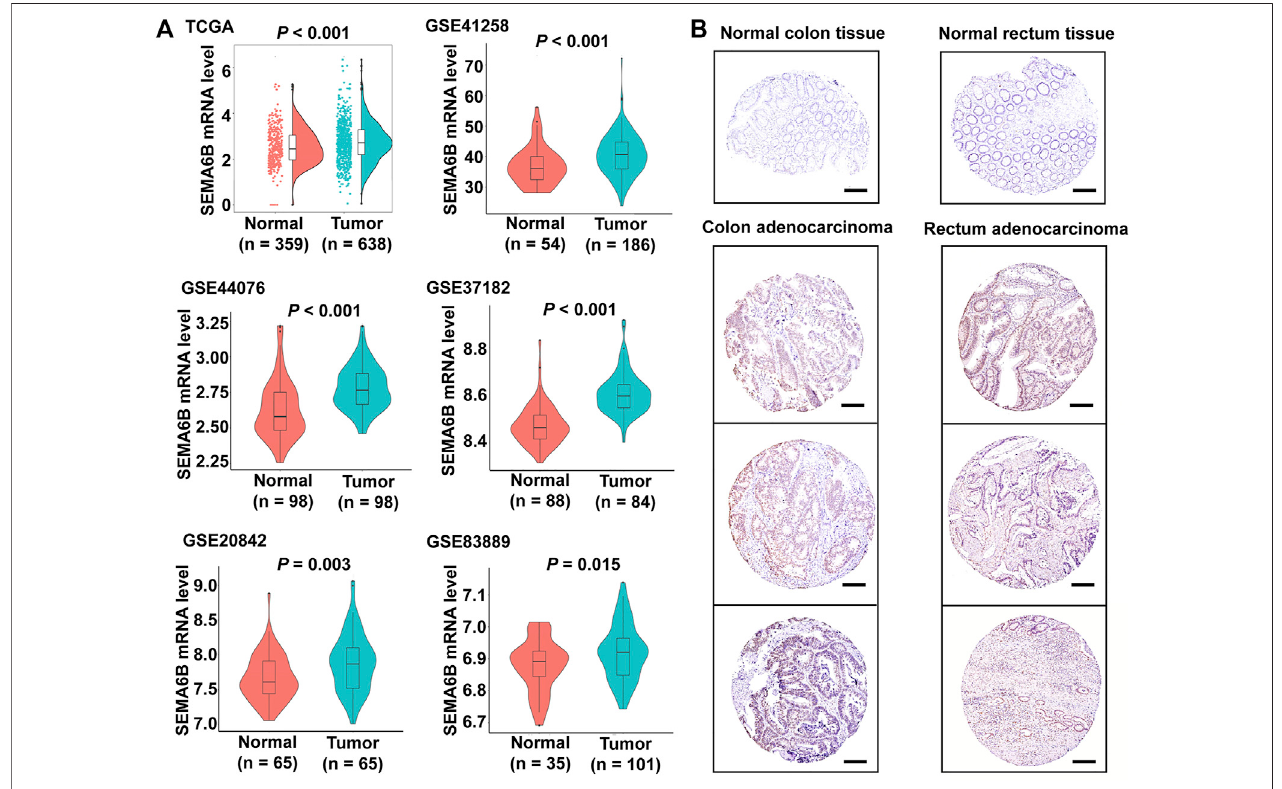
FIGURE 1 | SEMA6B mRNA and protein expression in CRC tissues and normal tissues. (A) The expression of SEMA6B mRNA in normal and tumor samples derivedfromTCGAandGEOdatabases. (B) RepresentativeimmunohistochemicalimagesofSEMA6BinCRCtissuesandcorrespondingnormaltissuesusingtheHPA database. Scale bars (cid:2) 200 µm.